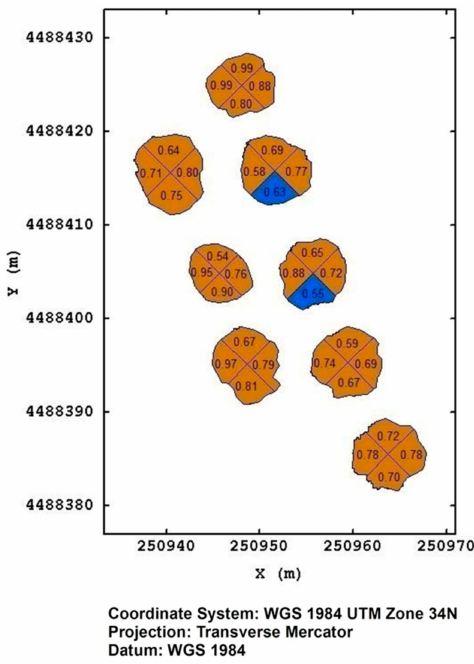
Figure 10. The prediction of the more probable severity class, together with its posterior probability at plant quadrant level, for eight plants at Torchiarolo field on August 2019. The brown color represents class1, blue color represents class